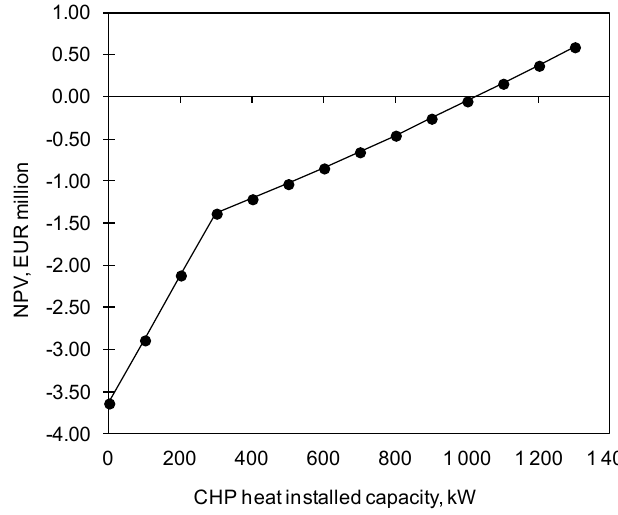
Figure 9. Results of optimization analysis.